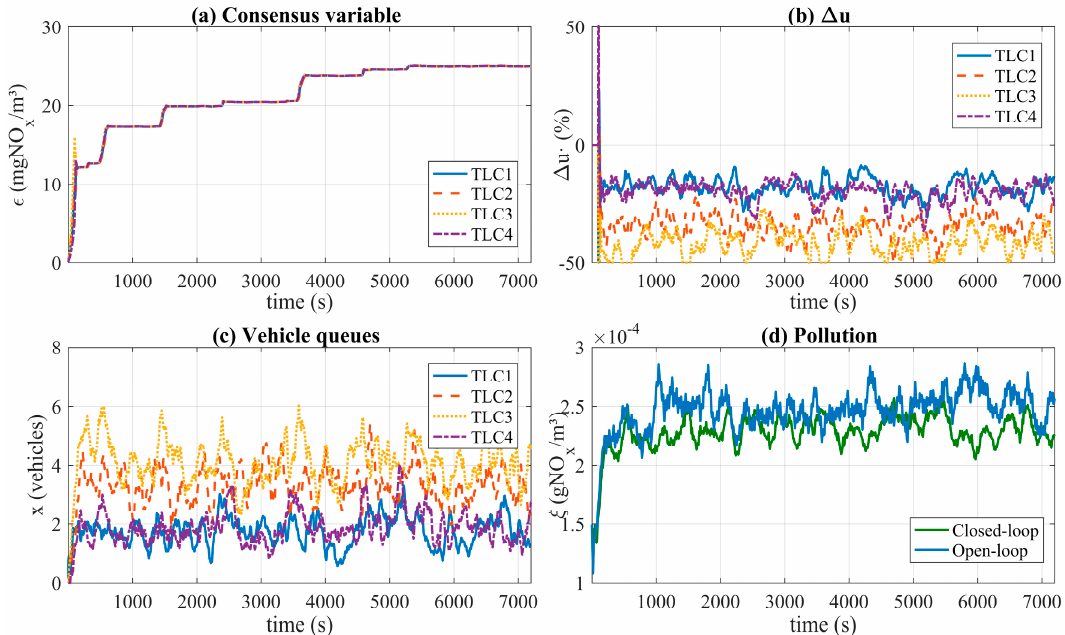
Figure 10. Close-loop simulation results: ( a ) Consensus variable ( ε ); ( b ) Control input ( ∆ u ); ( c ) Vehicle queues ( x ); ( d ) Pollution level ( ξ ) (closed-loop and